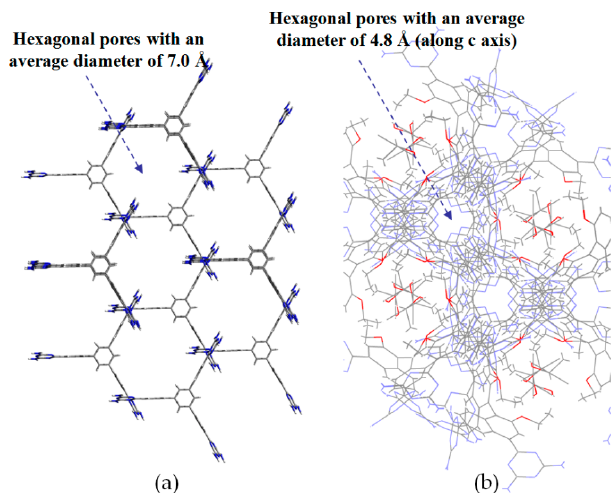
Figure 32. Crystalline Structures of HOFs assembled from building motif 34 ( a ) and chiral 36 ( b ). Table 3. Enantiomeric excess ( e.e. ) of racemic secondary alcohols separated by H36 .